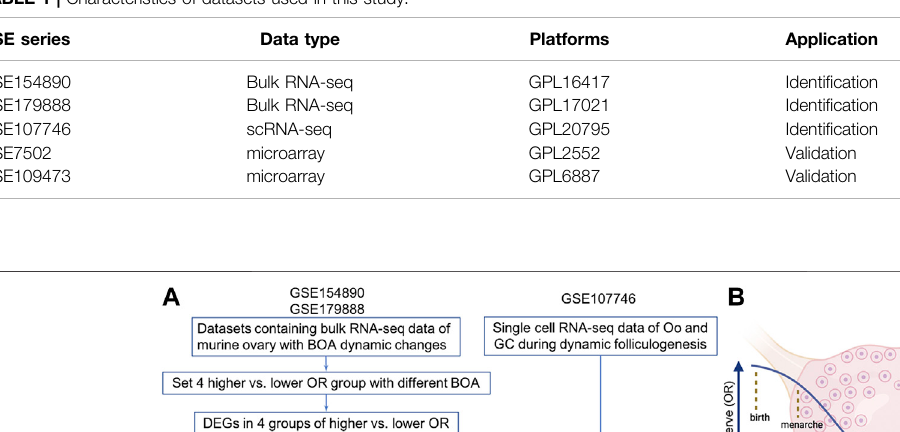
TABLE 1 | Characteristics of datasets used in this study.